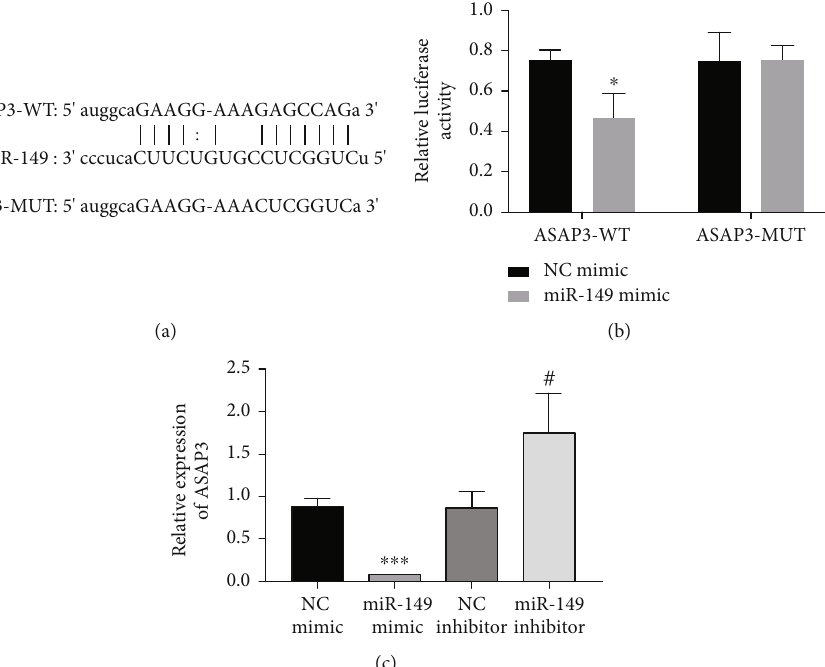
Figure 4: miR-149 targeted ASAP3. (a) starBase database predicted the targeted binding site of miR-149 and ASAP3. (b) Dual luciferase reporter gene assay veri fi ed the targeting relationship between miR-149 and ASAP3. (c) The mRNA expression of ASAP3 was detected by RT-qPCR. Compared with the NC mimic group, ∗ P < 0 : 05 . Compared with the NC inhibitor group, # P < 0 : 05